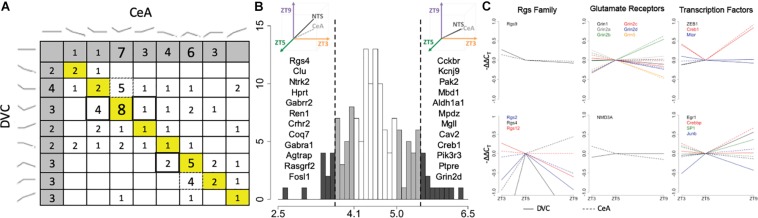
Pattern similarity and differences in the DVC and CeA. (A) Each cell shows the number of genes with the pattern combination found by matching the pattern in the DVC, rows, with the pattern in the CeA, columns (DVC patterns shown at left, CeA patterns shown at top). The 18 genes with the same pattern in the DVC and the CeA are included in the diagonal (yellow). Dotted box outlines highlight several cells with genes that have more diurnal dynamics in the CeA than in the DVC. Double box outlines highlight the reverse: cells with genes that have more diurnal dynamics in the DVC than in the CeA. The cells shaded in gray indicate transcripts with no diurnal pattern in the alternate brain region. (B) Histogram of the alignment scores of all 145 genes. Genes with low alignment scores (<3.7) like that illustrated at the top left and genes with high alignment scores (>5.5) like that illustrated in the top right are shaded in dark gray. The genes in these categories are listed in order of increasing alignment score within the corresponding region. Genes with moderately low (<4.1) and moderately high (>5.0) alignment scores are shaded in light gray. (C) The average −ΔΔCT values of Rgs family members (column 1), glutamate receptors (column 2), and transcription factors (column 3) with low, moderately low, moderately high, or high alignment scores are shown. All genes within the group with high or moderately high alignment scores are shown in the top row, while all genes within the group with low or moderately low alignment scores are shown in the bottom row. Each gene is shown in a different color with solid lines representing the gene expression data from DVC samples and dotted lines representing the gene expression data from CeA samples.